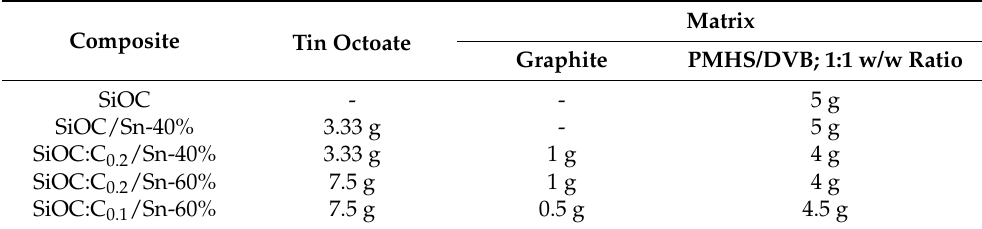
Table 1. Compositions of the preceramic